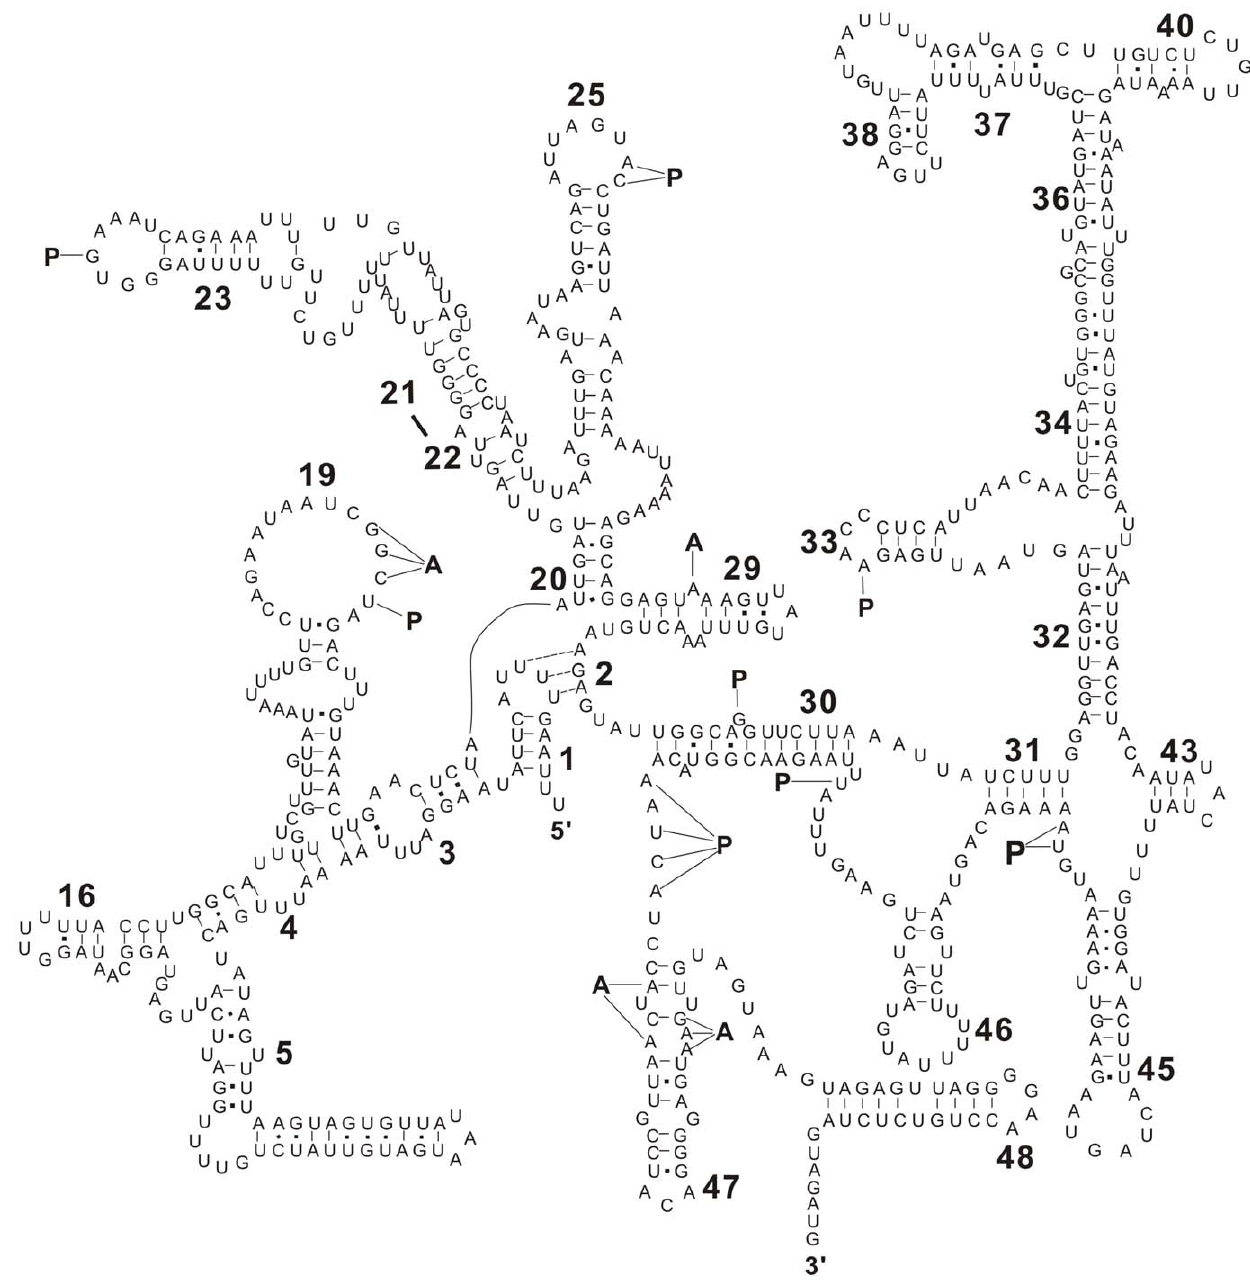
Figure 2. Predicted secondary structure for the small ribosomal RNA gene subunit ( rrn S) in B.procyonis mtDNA. Base-pairing is indicated as follows: Watson-Crick pairs by lines, wobble GU pairs by large dots and other non-canonical pairs by small dots. Conserved secondary structure elements are denoted by bold numbers (1–48) [29]. Binding sites for the amino-acyl trn (A) or peptidyl-transferase (P) [54] are indicated by lines.